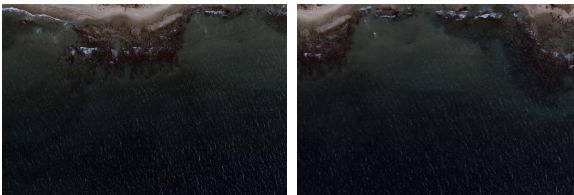
Figure 4a: Water with small objects - source (l.) and target (r.).